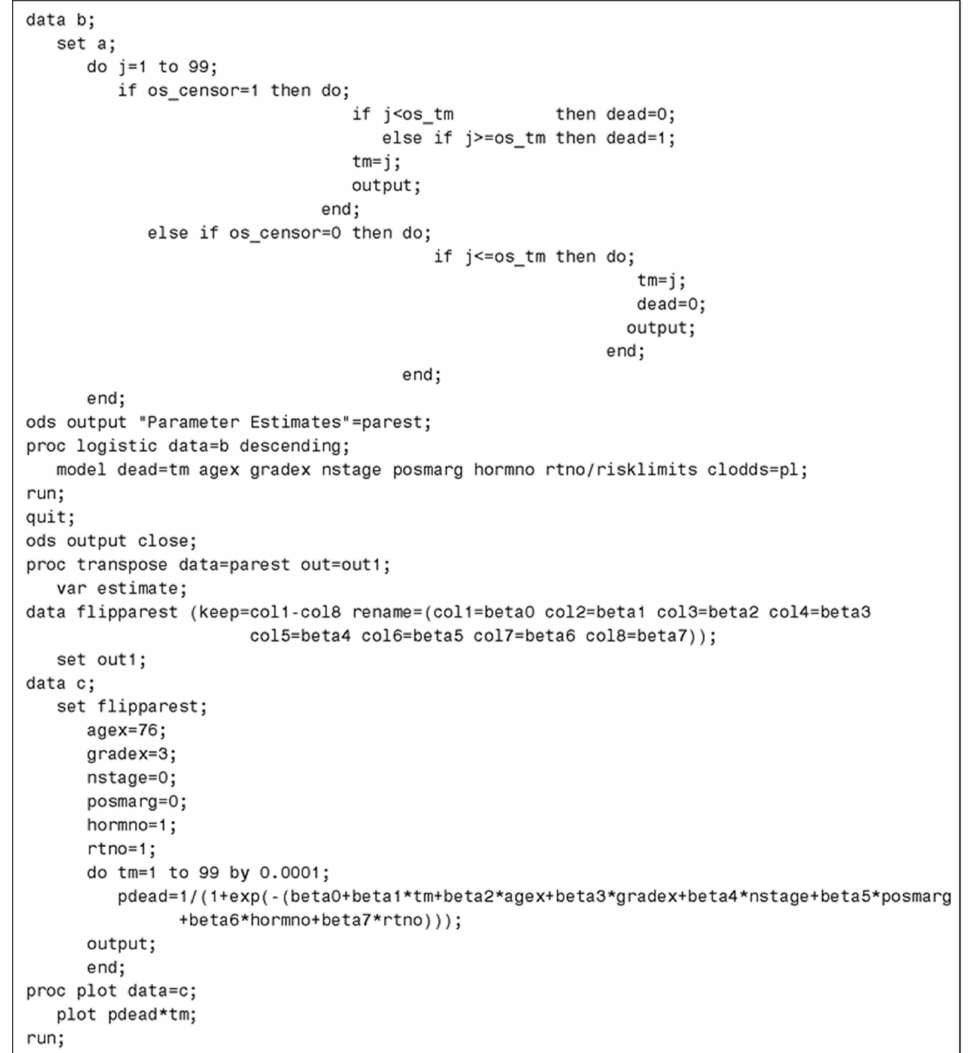
Figure 5. SAS code used to generate jump-point